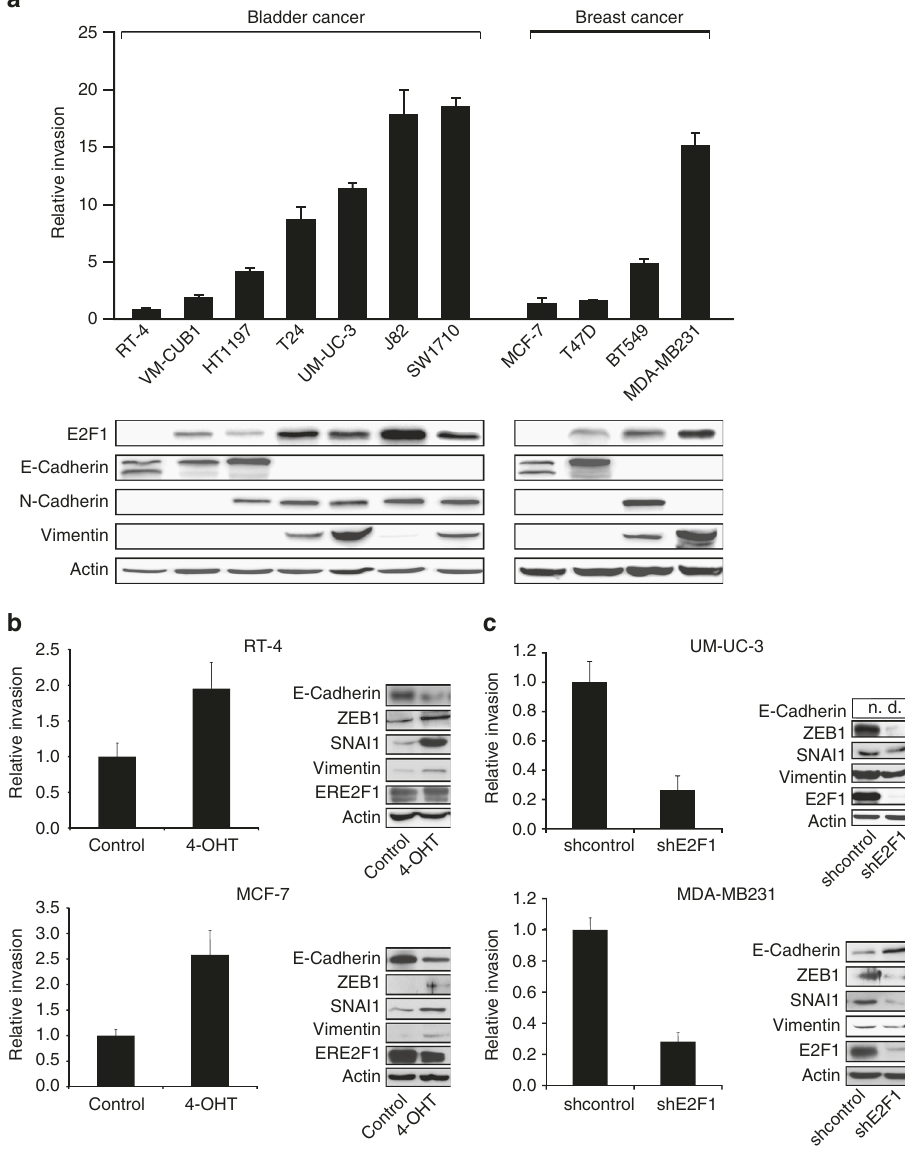
Fig. 2 Invasive potential and EMT marker expression in less-invasive and invasive human bladder and breast cancer cell lines. a Boyden chamber assay and western blot showing the invasive potential and the expression of E2F1 and EMT markers of various bladder and breast cancer lines. RT-4 was used as reference. b Indicated cells were transduced with adenoviral vector expressing the 4-OHT responsive estrogen receptor ( ER )-E2F1 fusion protein (Ad.ER-E2F1) to conditionally activate E2F1 nuclear translocation. After 24 h they were applied to Boyden chamber assay and induced with 4-OHT or ethanol as control ( left panels ) or harvested for protein isolation and western blotting ( right panels ). c Cells were transduced with adenoviral vector expressing shE2F1 or shcontrol . After 72 h cell invasion was determined ( left ). Protein level and shE2F1 knockdown is indicated by immunoblots ( right ). All fi gures are representatives of at least three independent experiments. Error bars indicate s.e.m., n.d . not